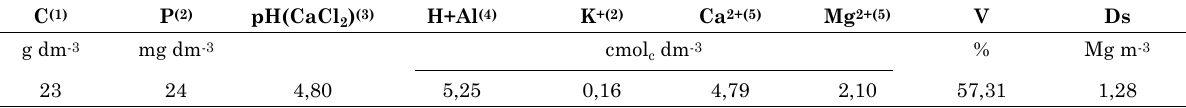
Quadro 1. caracterização química e densidade do solo (Ds) na camada de 0,00-0,20 m de um latossolo vermelho Distroférrico típico, em outubro de 2009, antes da implantação dos